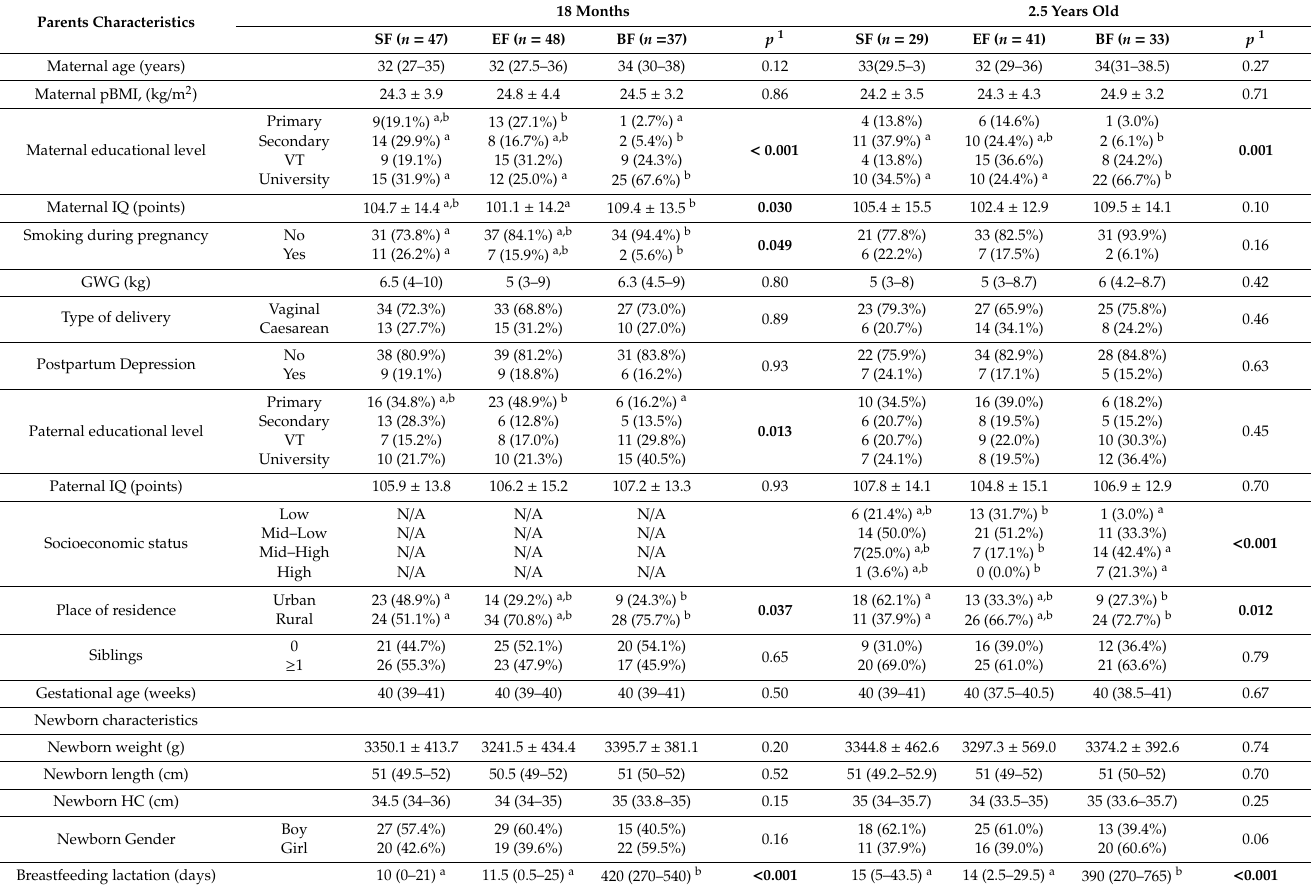
Table 1. Parents and children baseline characteristics depending on their type of